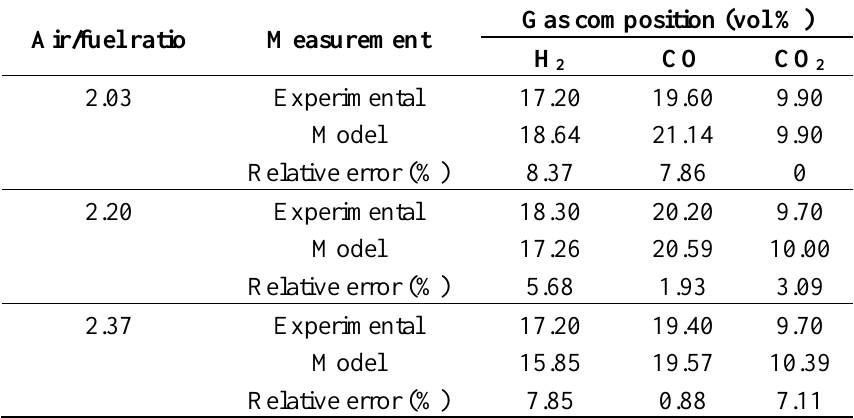
Table 1. The comparison of predicted results with the experimental data from